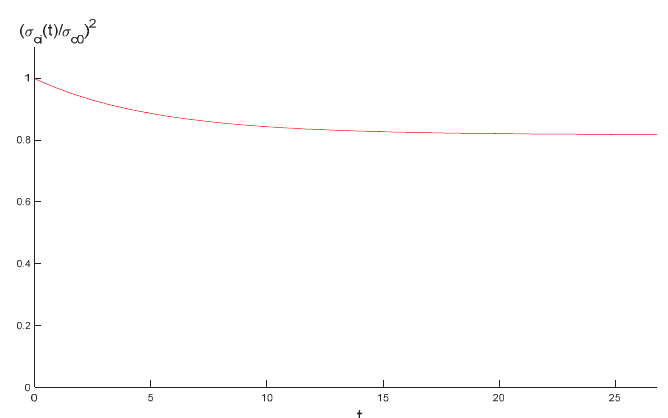
σ ( ) t ) to original strength ( 2 ( t ) ) to original strength ( σ 2 i c c i